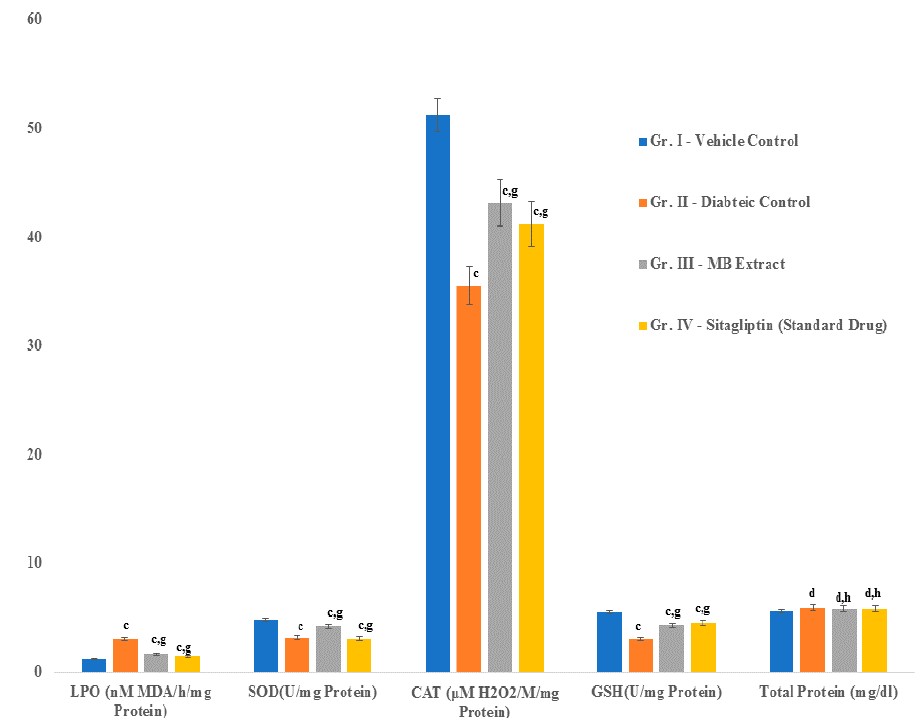
Figure 8. Changes in serum antioxidant levels in diabetic rats treated with DBT34 microbial extract or sitagliptin. Data are the mean ± S.E.M. ( n = 5); letters indicate significant di ff erences between the control and treatment groups c ( p ≤ 0.001); and g ( p ≤ 0.001) are significant. Whereas, d and h are non significant.